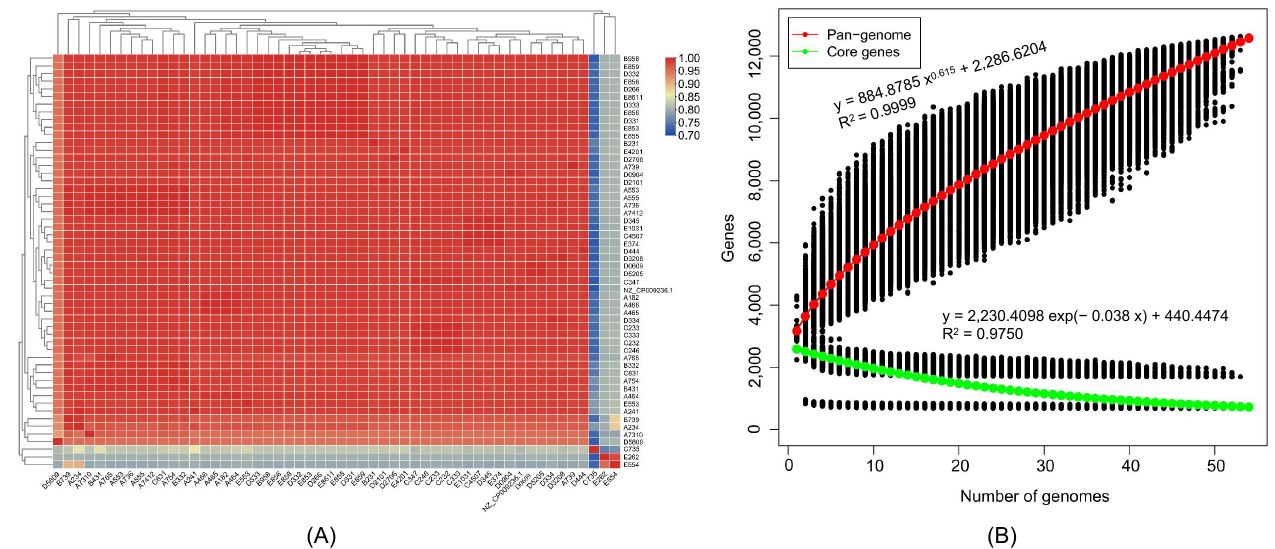
Figure 5. ANI, pan-genome and core gene analyses of Lactobacillus plantarum . ( A ) ANI heatmap of 54 strains of L. plantarum ; ( B ) pan-genome and core gene trend map of 54 strains of L. plantarum